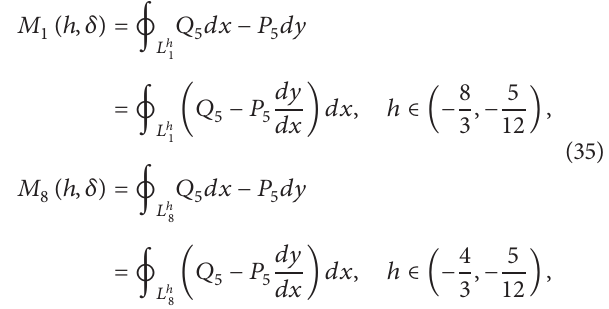
8 saddles, 𝑆 = (1, 2) , 𝑆 = (2, 1) , 1 2 = (−1, −2) , 𝑆 = (−2, −1) 5 6